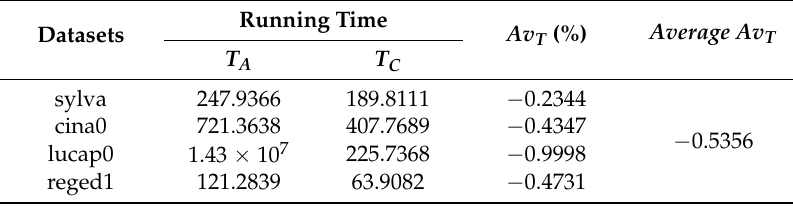
Table 7. Variation in the ratio of running time for Alpha-investing and ConInd